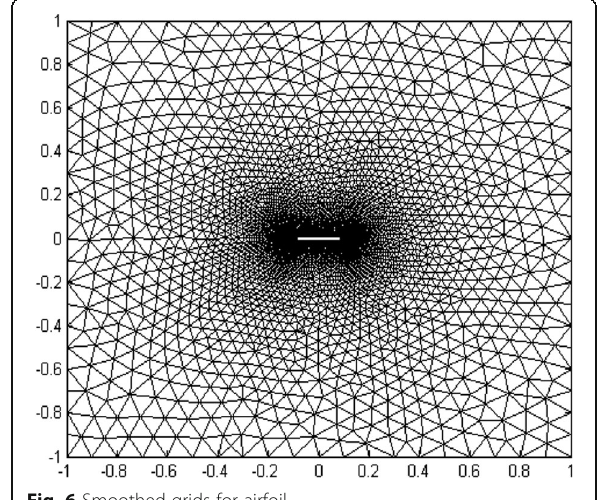
Fig. 6 Smoothed grids for airfoil